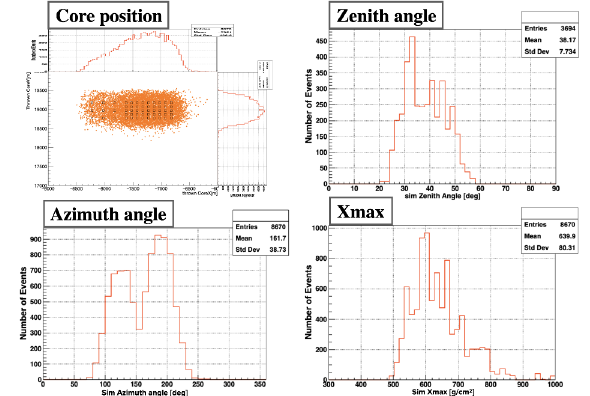
(cid:10) (cid:11) X true (circle), max (cid:10) (cid:11) X true (plus), and max